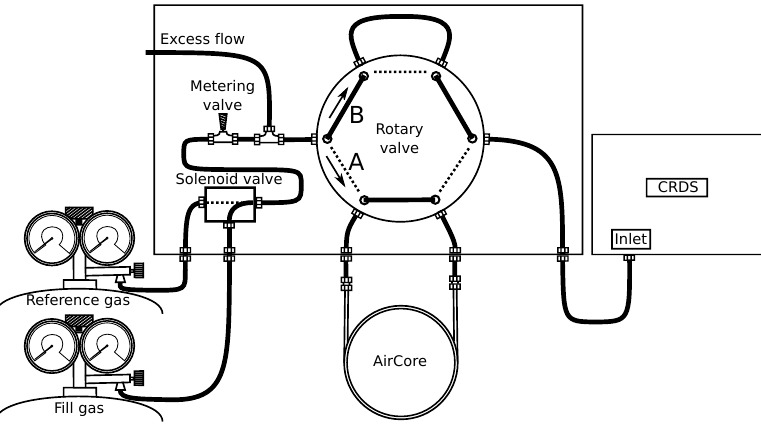
Figure 4. A schematic of the analysis setup.